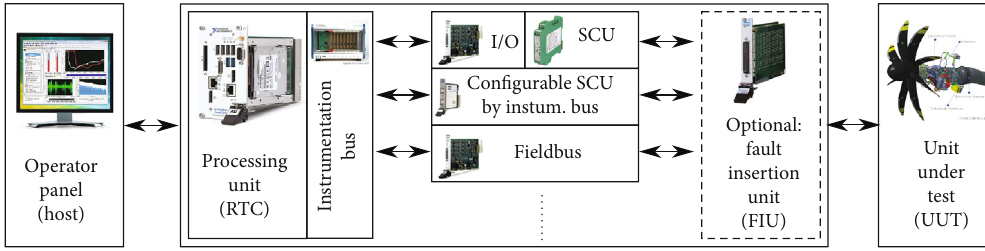
Figure 6: General scheme for avionic veri fi cation